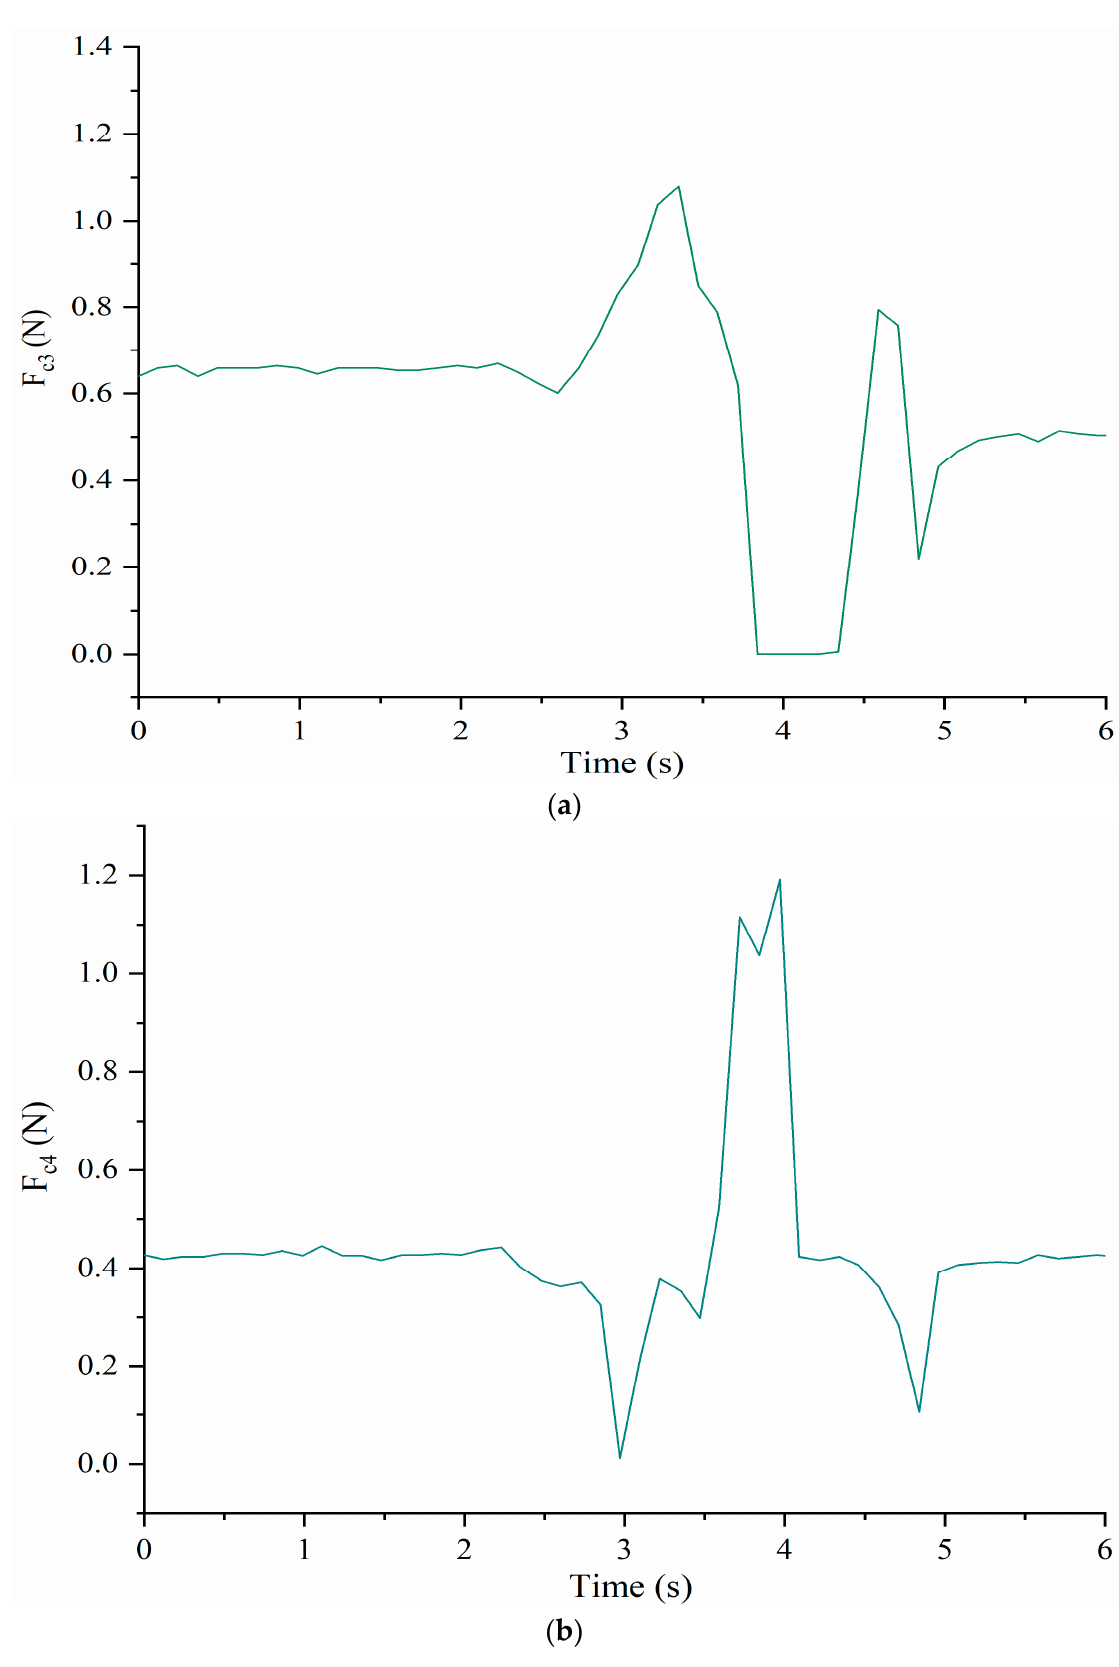
Figure 13. Acquired forces between the cables and shoulder during a full rotation: ( a ) F c3 ; ( b ) F c4.